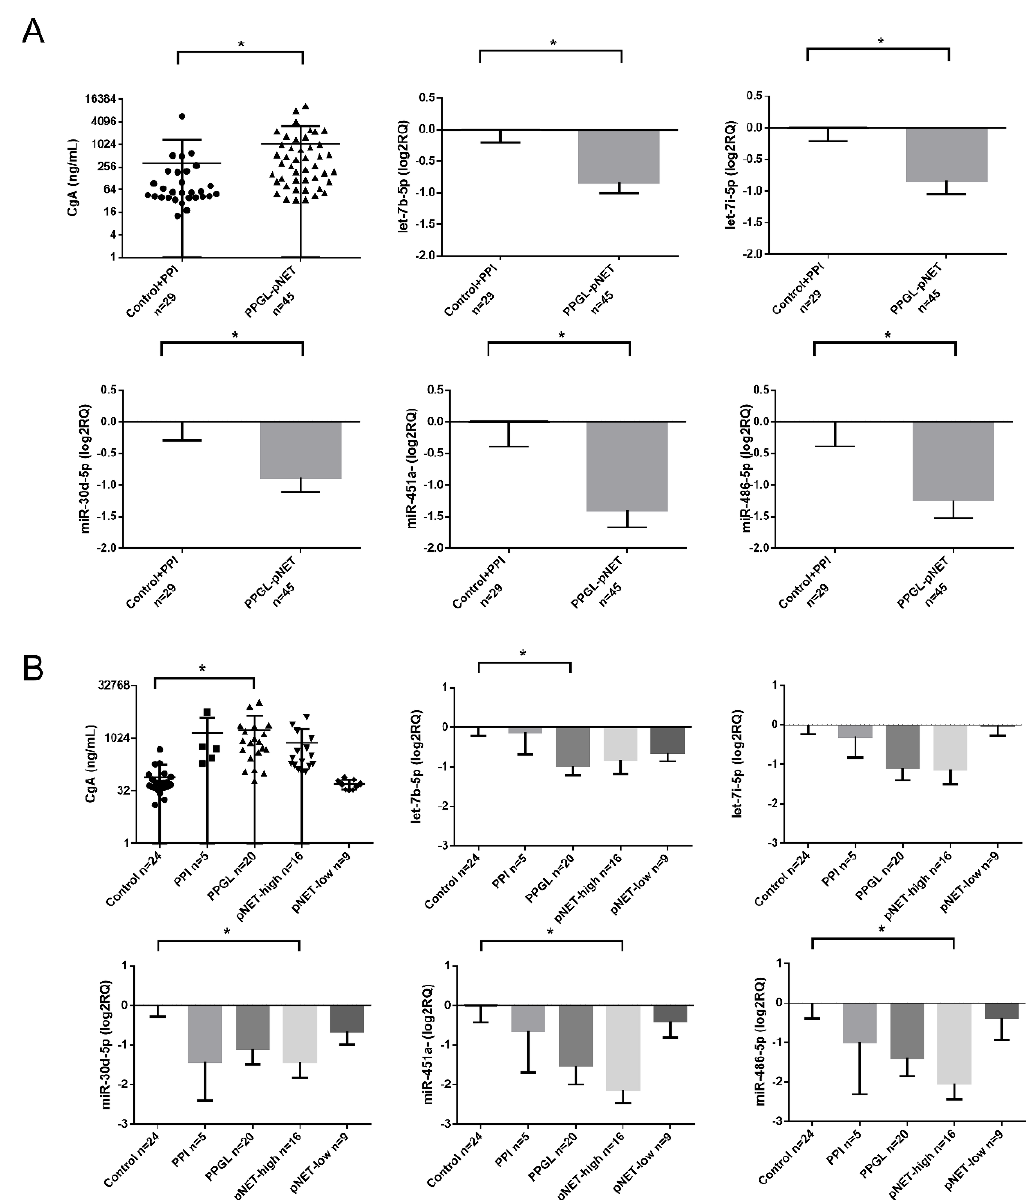
Figure 2. ( A , B ) CgA levels and miRNA expression among controls and pNET / PPGL samples. Error bars Figure 2. ( A,B ) CgA levels and miRNA expression among controls and pNET/PPGL samples. Error indicate mean ± SE. * represents p -value < 0.05. bars indicate mean ± SE. * represents p -value < 0.05 . Table 2. CgA correlation with miRNA expression in the validation set (CgA vs. –dct). All